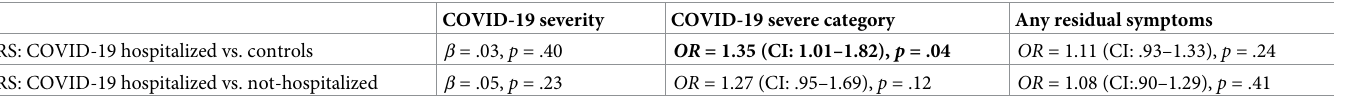
Table 4. Associations between COVID-19 PRS and COVID-19 severity and residual symptoms in participants of European ancestry. COVID-19 severity COVID-19 severe category Any residual